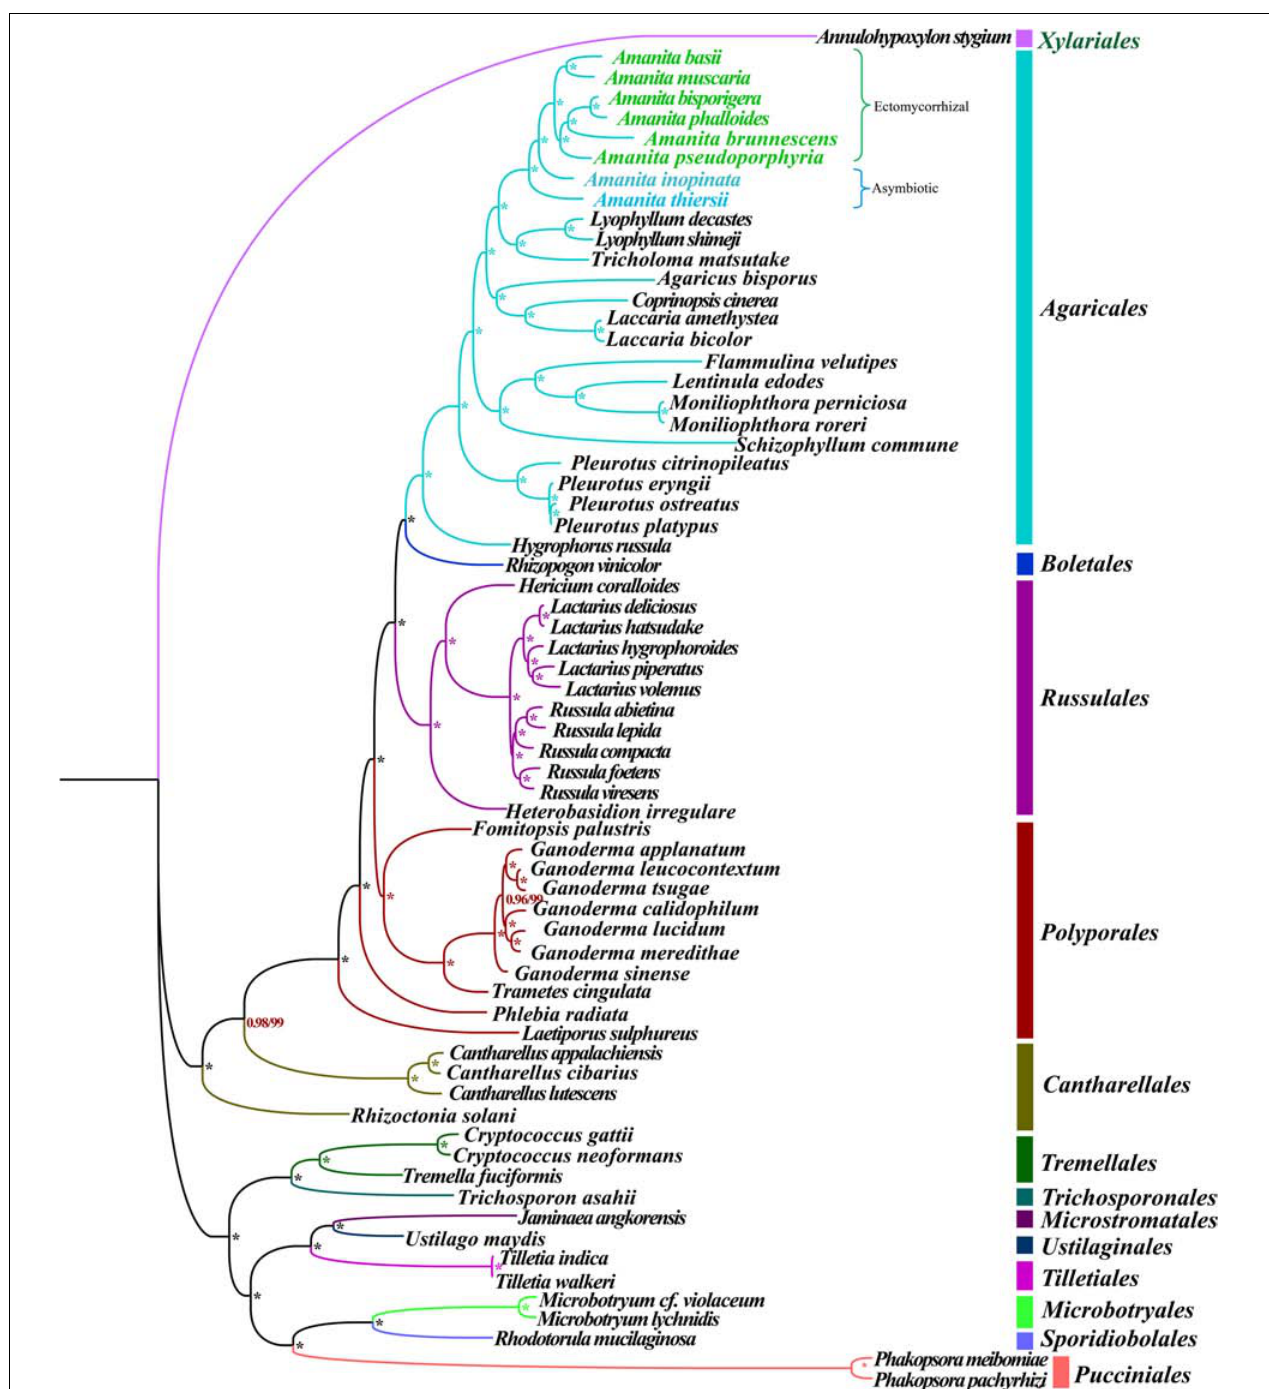
FIGURE 2 | Molecular phylogeny of 66 Basidiomycete species based on BI and ML analysis of 15 PCGs and two rRNA genes. Support values are BPP (before slash) and BS values (after slash). The asterisk indicates that the BPP value is 1 and the BS value is 100 of the branch. Species and NCBI accession numbers for genomes used in the phylogenetic analysis are provided in Supplementary Table S6